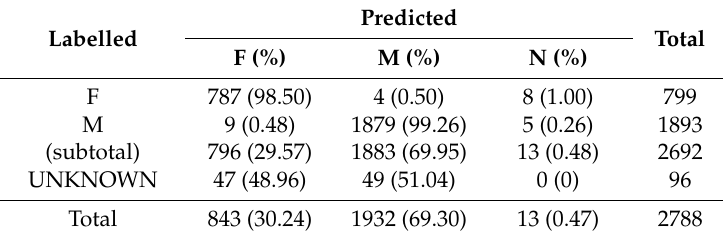
Table 2. sEst-based sex estimation for test specimens.